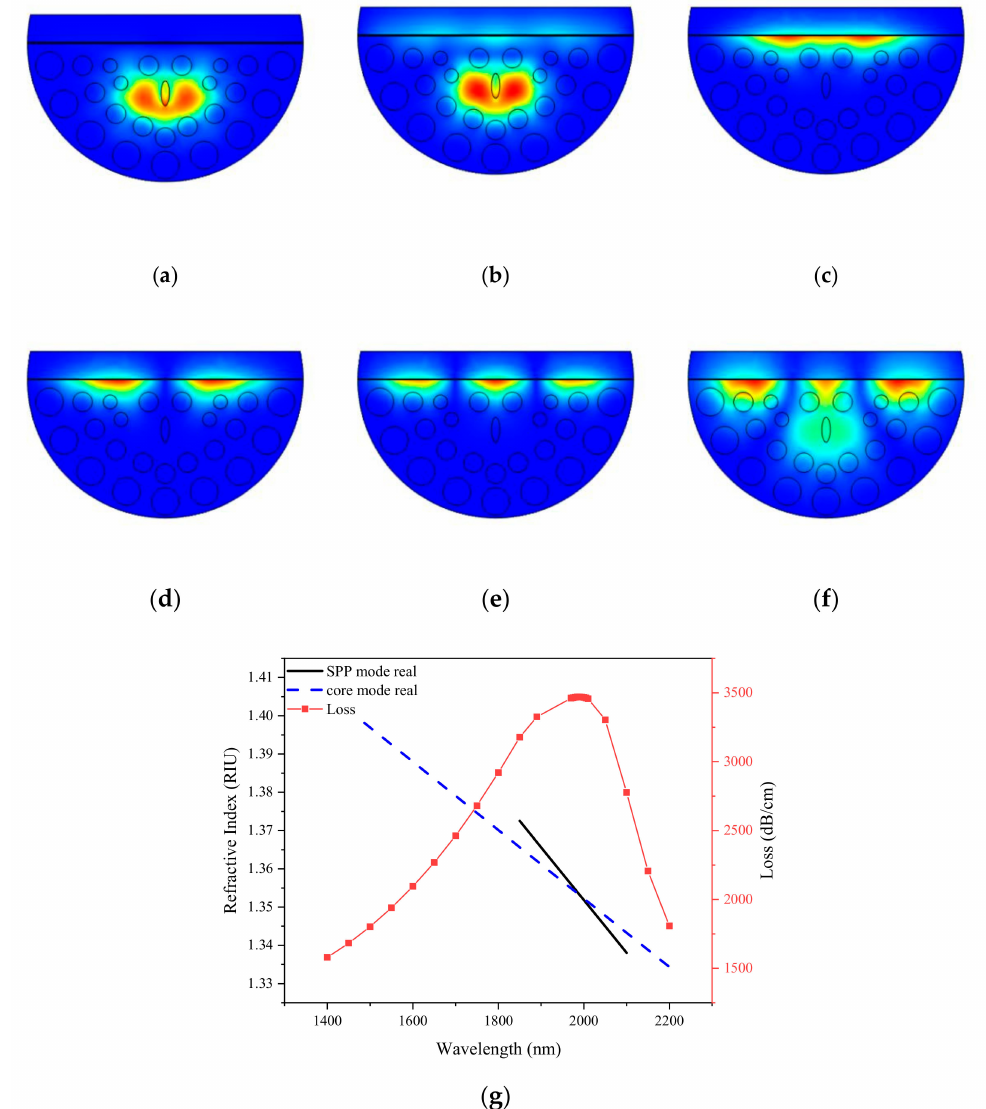
Figure 2. The simulated ( a ) X -polarized core mode; ( b ) Y -polarized core mode; ( c ) 1-SPP mode; ( d ) 2-SPP mode; ( e ) 3-SPP mode; ( f ) Coupling mode; ( g ) The real part (dispersion) of the effective refractive index under the core mode and SPP mode, and the change of the loss along the y-polarization direction with the wavelength. ( d 1 = 0.5 µ m, d 2 = 0.7 µ m, d 3 = 1 µ m, Λ = 2 µ m, tz = 25 nm, RI = 1.40, ts = 30